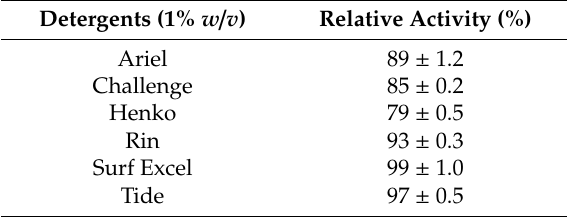
Table 4. Detergent compatibility of the purified protease